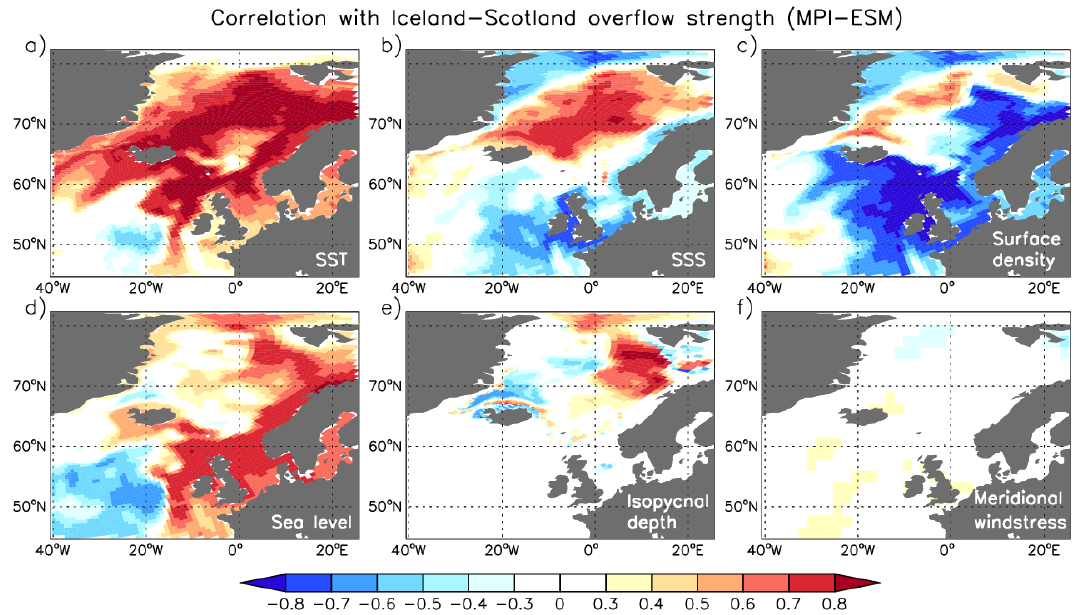
Figure 6. Zero-lag correlation coefficients between the Iceland–Scotland overflow strength and (a) the SST, (b) the SSS, (c) the surface density, (d) the sea surface height (linearly detrended prior to the analysis to account for the non-closed water budget between the atmosphere and the ocean), (e) the depth of the isopycnal σ = 27 . 8kgm − 3 and (f) the meridional wind stress component in MPI-ESM. The correlation analysis is based on annual values for the period AD850 to 1849 with a 21-year running mean filter applied. Only correlation coefficients statistically significant at the 95% confidence level are shown (significance level: